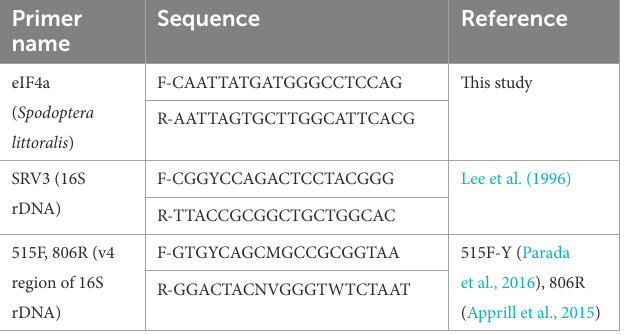
TABLE 2 Primers used for quantitative PCRs and 16S amplicon